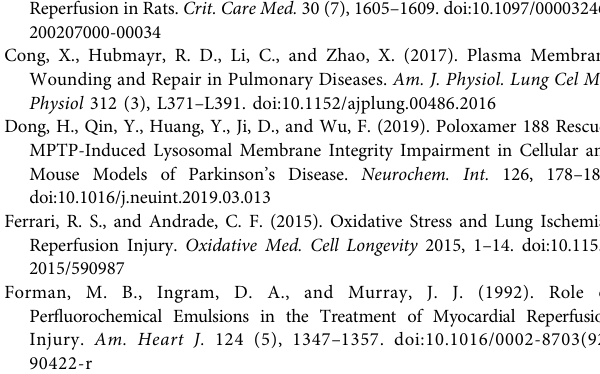
Supplementary Figure 1 | Effect of P188 on pulmonary artery pressure ( Δ PAP). Change in pulmonary artery pressure ( Δ PAP) from baseline was measured continuously during 60 min reperfusion. Data are mean ± SD (6 rats per group); *** p < 0.001 compared with the control group; ### p < 0.001 compared with the IR group. Supplementary Figure 2 | Effect of ammonium pyrrolidinedithiocarbamate (PDTC) on hypoxia/reoxygenation (HR) injury in MLE-12 cells. NF- κ B phosphorylation, I κ B- α degradation, and CXCL-1level were measured at 2 h after HR. NF- κ B was detected using (A) immuno fl uorescence staining and (B) Western blotting. β -actin served as the loadingcontrol.Representativeblotandimageareshown.Dataaremean ± SD( n (cid:2) 6per group); * p < 0.05, ** p < 0.01,*** p < 0.001 compared with the control group. # p < 0.05, ## p < 0.01, ### p < 0.001 compared with the HR